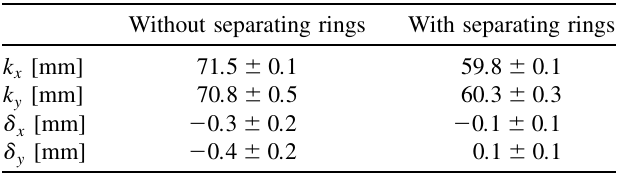
TABLE II. Scaling factors k and offsets (cid:3) of the electrical center in x and y for the pickup with and without the separating